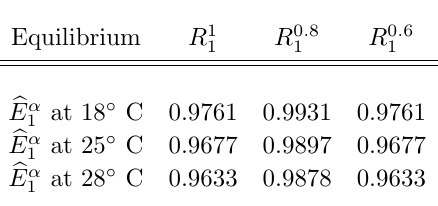
Table 2. Stability of (cid:98) E α